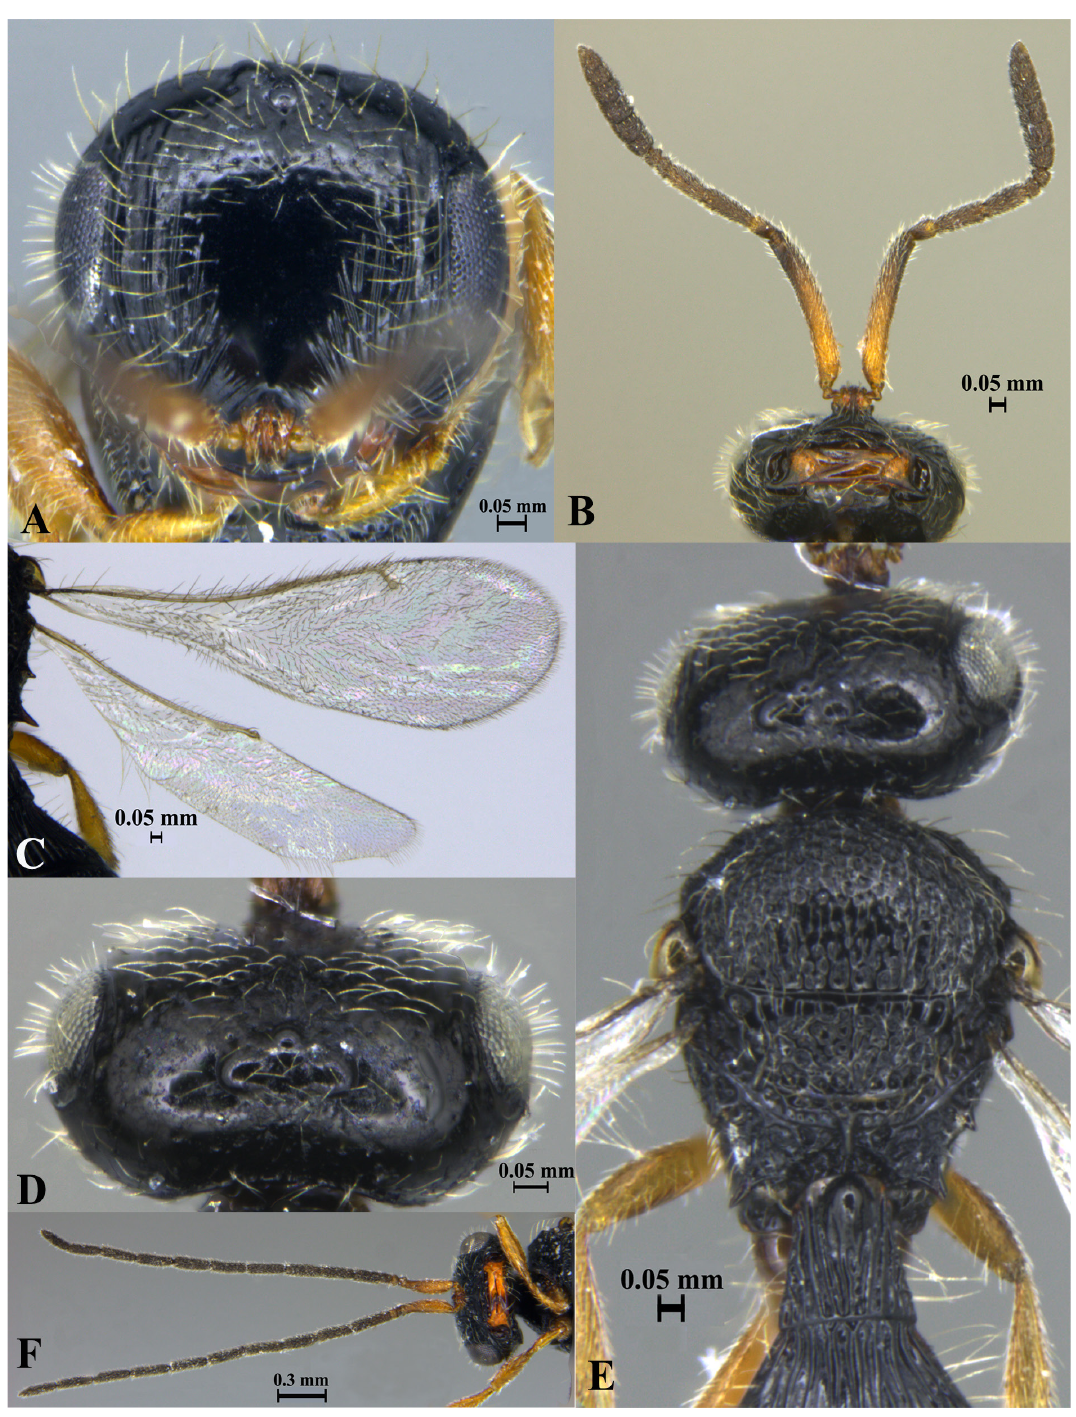
Fig. 2. Odontoscelio agnieleae sp. nov. A–E . Holotype, ♀ (ICAR-NBAIR P3963). A . Frons. B . Antennae. C . Wings. D . Vertex. E . Head and mesonotum. F . Paratype, ♂ (ICAR-NBAIR P3968),